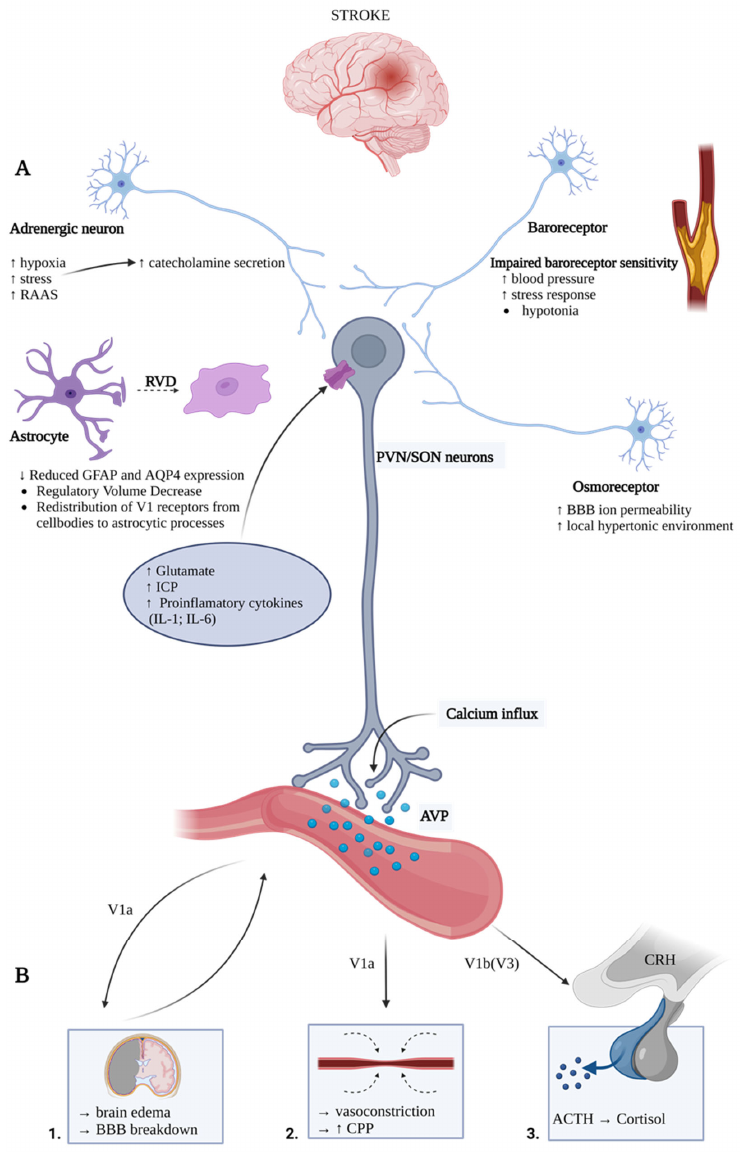
Figure 1. Main mechanisms causing arginine ‐ vasopressin (AVP) release during stroke ( A ) and main local deteriorating effects caused by excessive AVP release ( B ). AVP neurons receive dense afferent input from baroreceptors, osmoreceptors, adrenergic, and glutaminergic neurons. Stroke induces the dysregulation of baroreceptors and the renin ‐ angiotensin ‐ aldosterone system, and increases the sympathetic stimulation of the paraventricular nucleus of hypothalamus (PVN) neurons ( A ). After